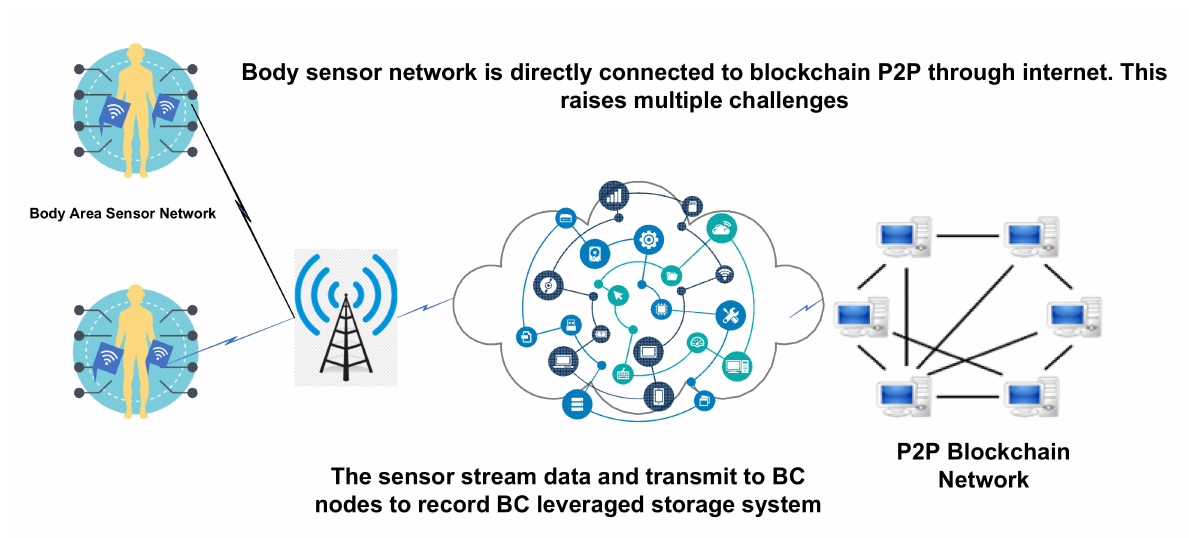
Figure 7. Body area sensors network with